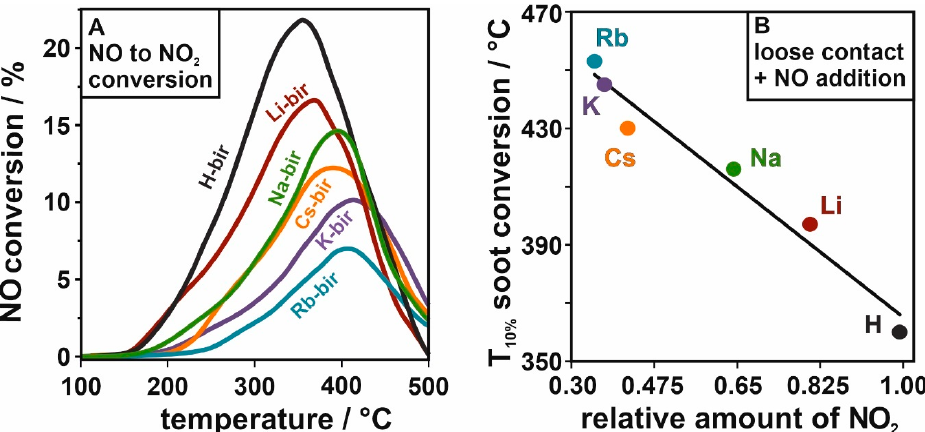
Figure 9. The conversion of NO to NO 2 ( A ) and the resulting correlation between the soot conversion and relative amount NO 2 formed during the test, normalized to the highest amount for H-bir; ( B ) for the investigated birnessite.